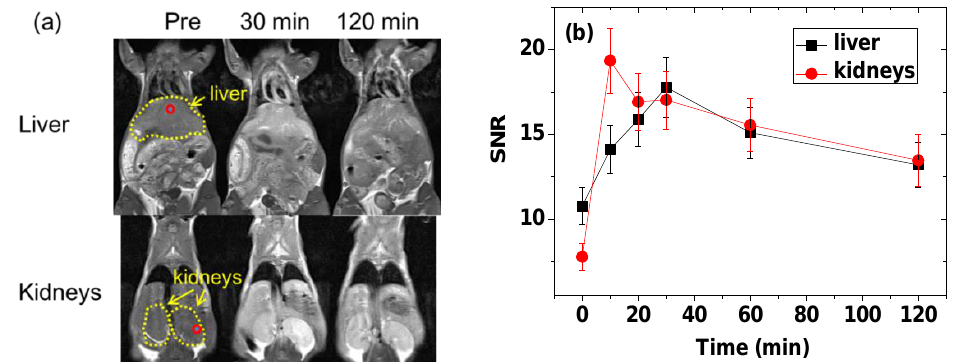
Figure 7. ( a ) In vivo T 1 MR images of a mouse under a 3.0 tesla MR field before (labeled as “Pre”) and after intravenous administration of the solution sample into the mouse’s tail: the small circles indicate ROIs and the dotted circles indicate the liver and kidneys. The administration dose was ~0.1 mmol Gd/kg. ( b ) SNR plots of the ROIs in the liver and kidneys of the mouse as a function of time (SNR: signal-to-noise ratio; ROI: region-of-interest).